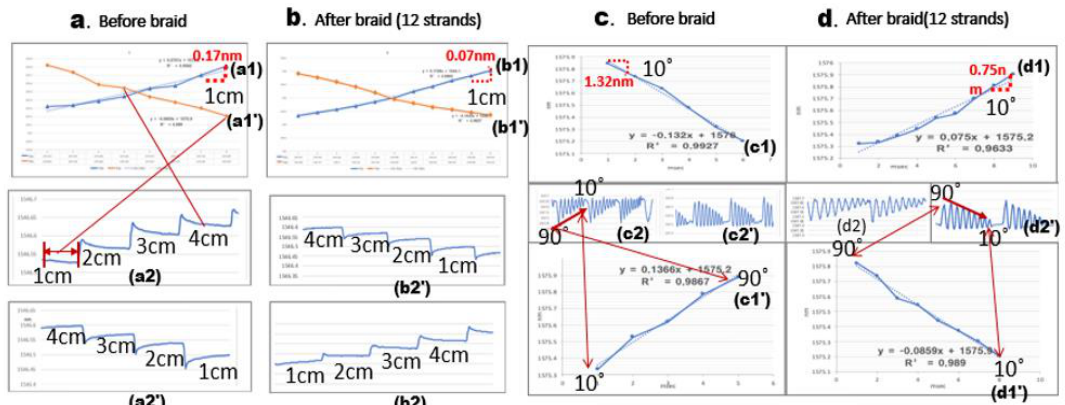
Figure 8. The morphology of the sensor's length and angle unit wavelength variations and the maximum and minimum values of the sensors before and after braiding under the same conditions ( a1 , a1’ , a2 , a2’ , c1 , c1’ , c2 , c2’ ). The linearity of the wavelength variation through the trend line. ( b1 , b1’ , b2 , b2’ , d1 , d1’ , d2 , d2’ ): a1, a1’, b1, b1’: 1cm stress-strain response graph for displacement. a2, a2’, b2, b2’: The morphology of the wavelength shift ( a1 , a1’ , b1 , b1’ ) in real time (nm/msec) measured in the interrogator. ( c1 , c1’ , d1 , d1’ ): 1° stress-strain response graph for displacement. ( c2 , c2’ , d2 , d2’ ): The real time (nm/msec) morphology of the wavelength shift ( c1 , c1’ , d1 , d1’ ) in the interrogator.